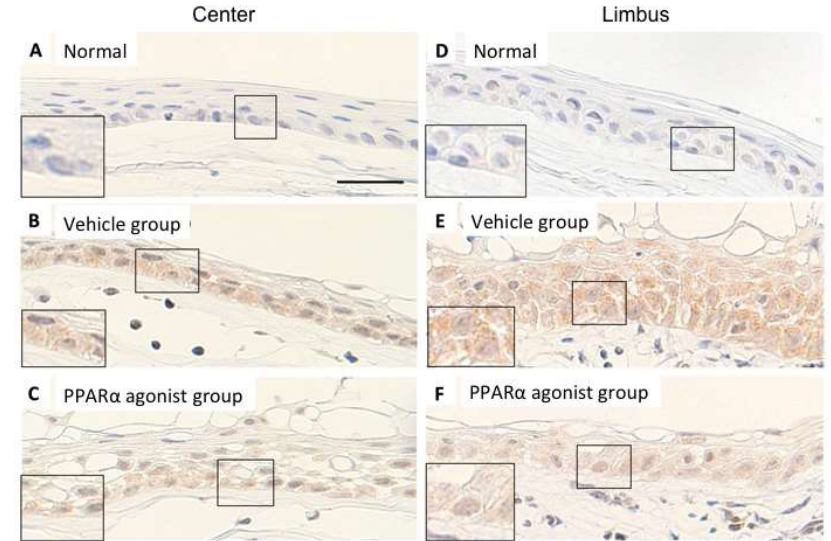
Figure 9. The expression of MCP-1 in rat normal cornea and in alkali-burned cornea in the vehicle and PPAR α agonist groups at day 1. The expression of MCP-1 could not be detected in the epithelial basement cells in normal cornea of center ( A ) and of limbus ( D ). In the alkali-burned cornea of center ( B , C ) and limbus ( E , F ) in the Vehicle ( B , E ) and PPAR α agonist ( C , F ) groups, diffuse expression of MCP-1 in the epithelial basement cells was observed during re-epithelialization. However, the expression of MCP-1 was weaker in the PPARα agonist group ( C , F ) compared to these regions of the Vehicle group ( B , E ), suggesting that PPARα agonist inhibited the expression of MCP-1 in the epithelial basement cells. Scale bar: 20 μm.